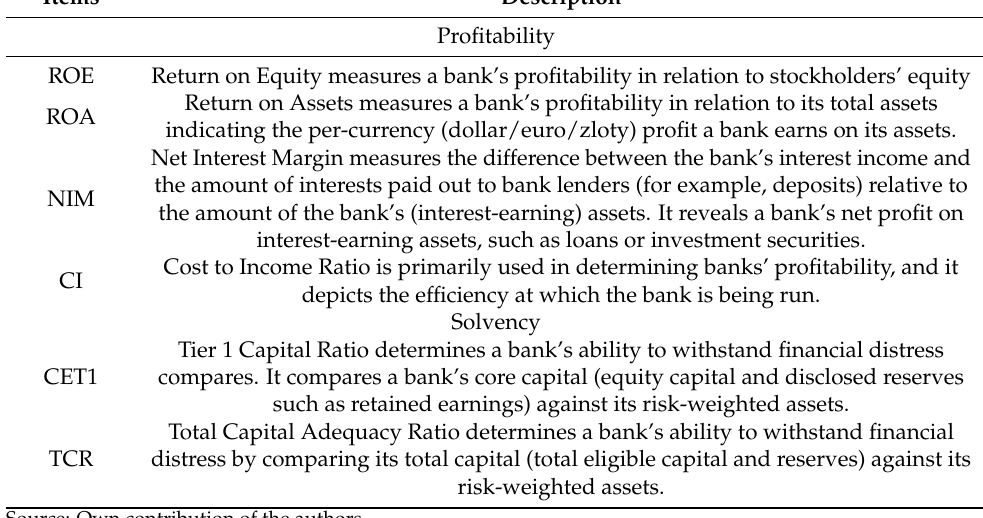
Table 2. The profitability and solvency